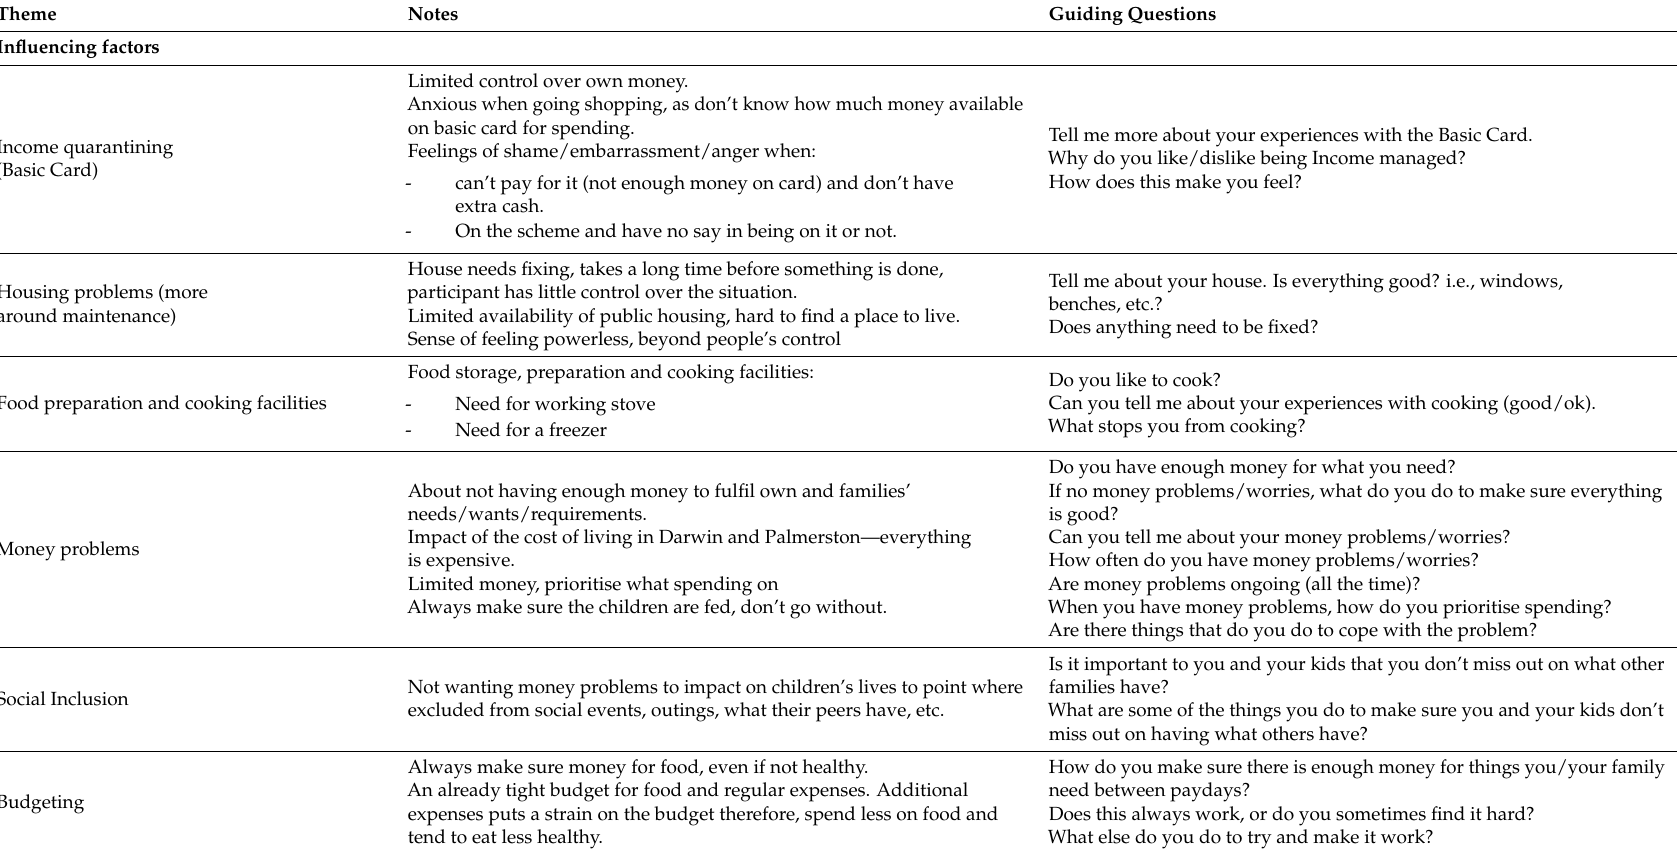
Table A1. Inductive development processes towards key guiding questions for the in-depth qualitative